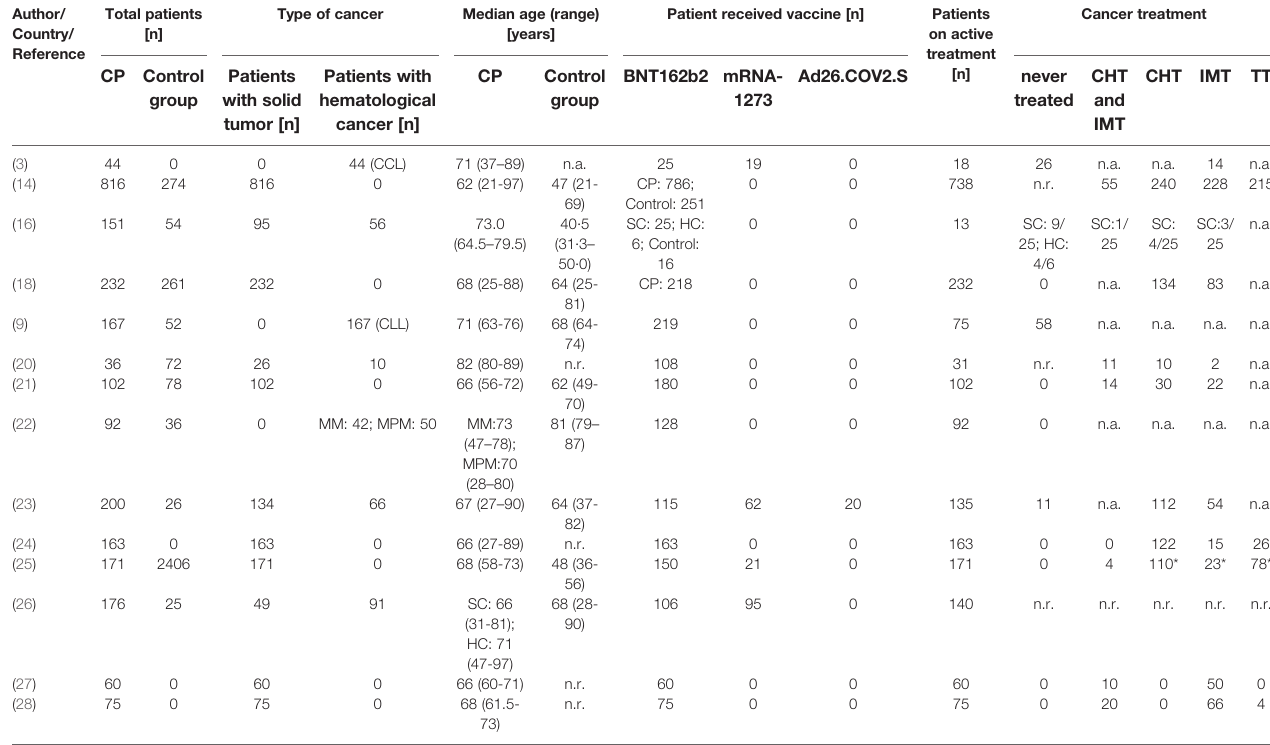
TABLE 2 | Summary of COVID-19 vaccination trials in cancer patients under diverse therapies. Author/ Total patients Country/ Reference